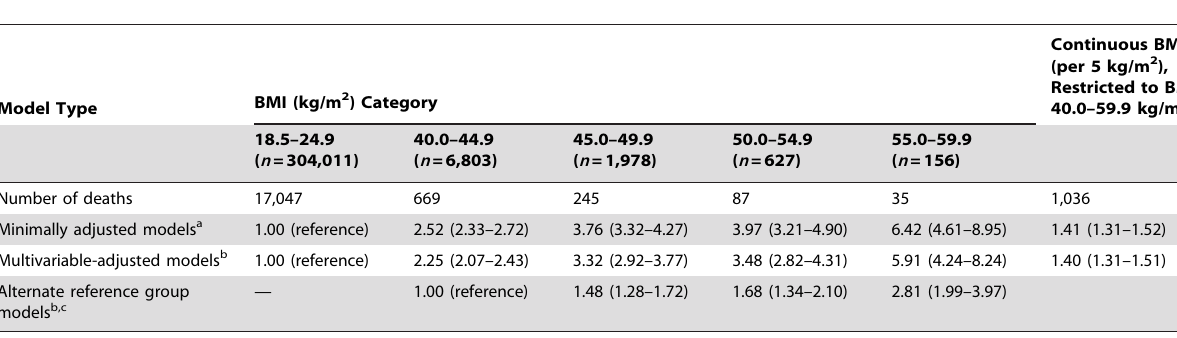
Table 4. Hazard ratios and 95% confidence intervals for risk of death by BMI category.